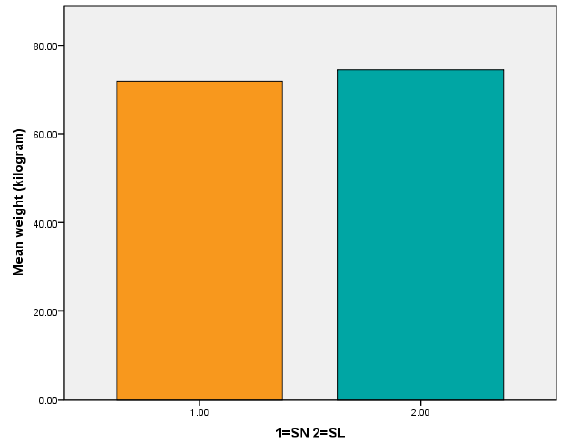
Figure (6): shocked patients received normal saline versus shocked patient received Furosemide in terms of blood urea, there is significant statistical difference